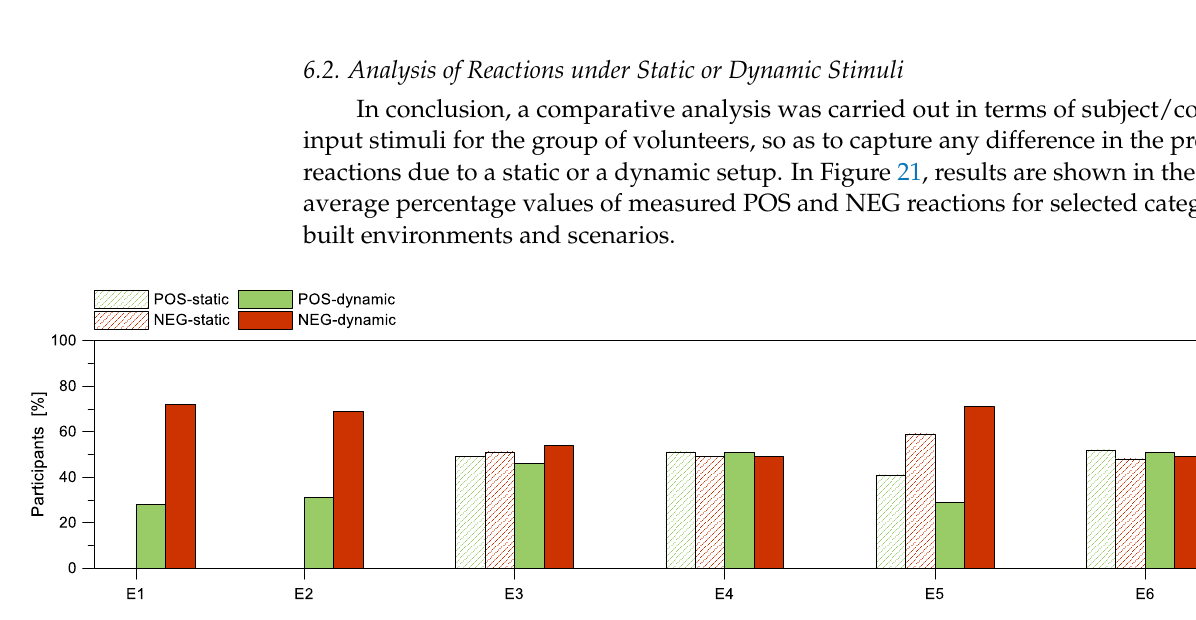
Figure 21. Analysis of prevailing POS or NEG reactions (average percentage results for the group of participants), as a function of context, as obtained from the static and dynamic VR experiments.